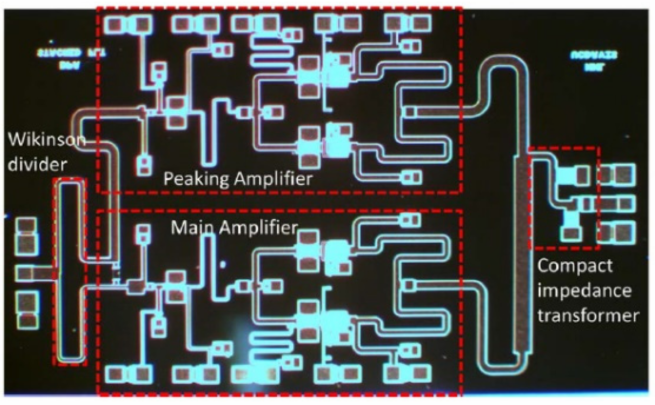
Figure 23. Stacked-FET MMIC DPA in 120 nm GaAs pHEMT [96].